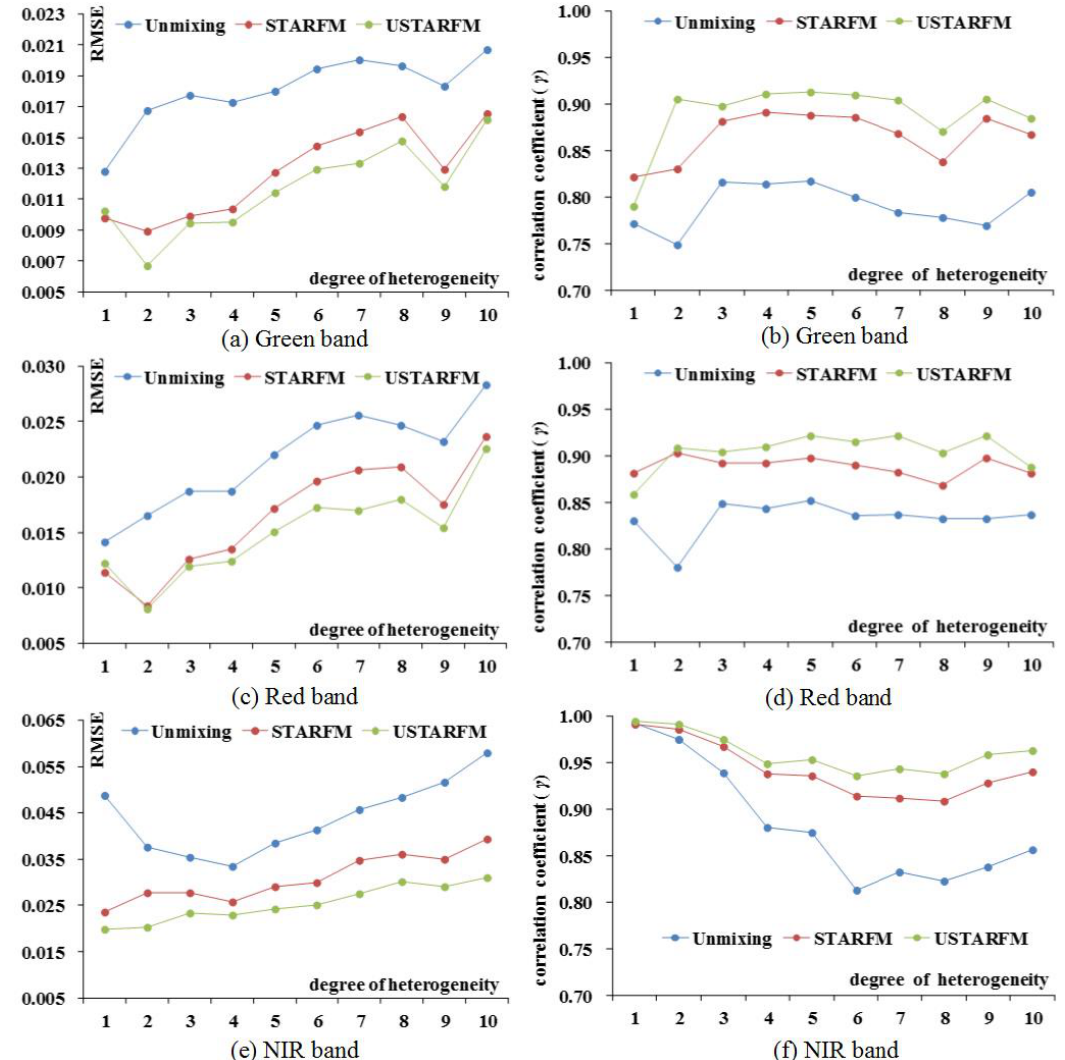
Figure 5. γ and RMSE of the three methods at different heterogeneity levels.